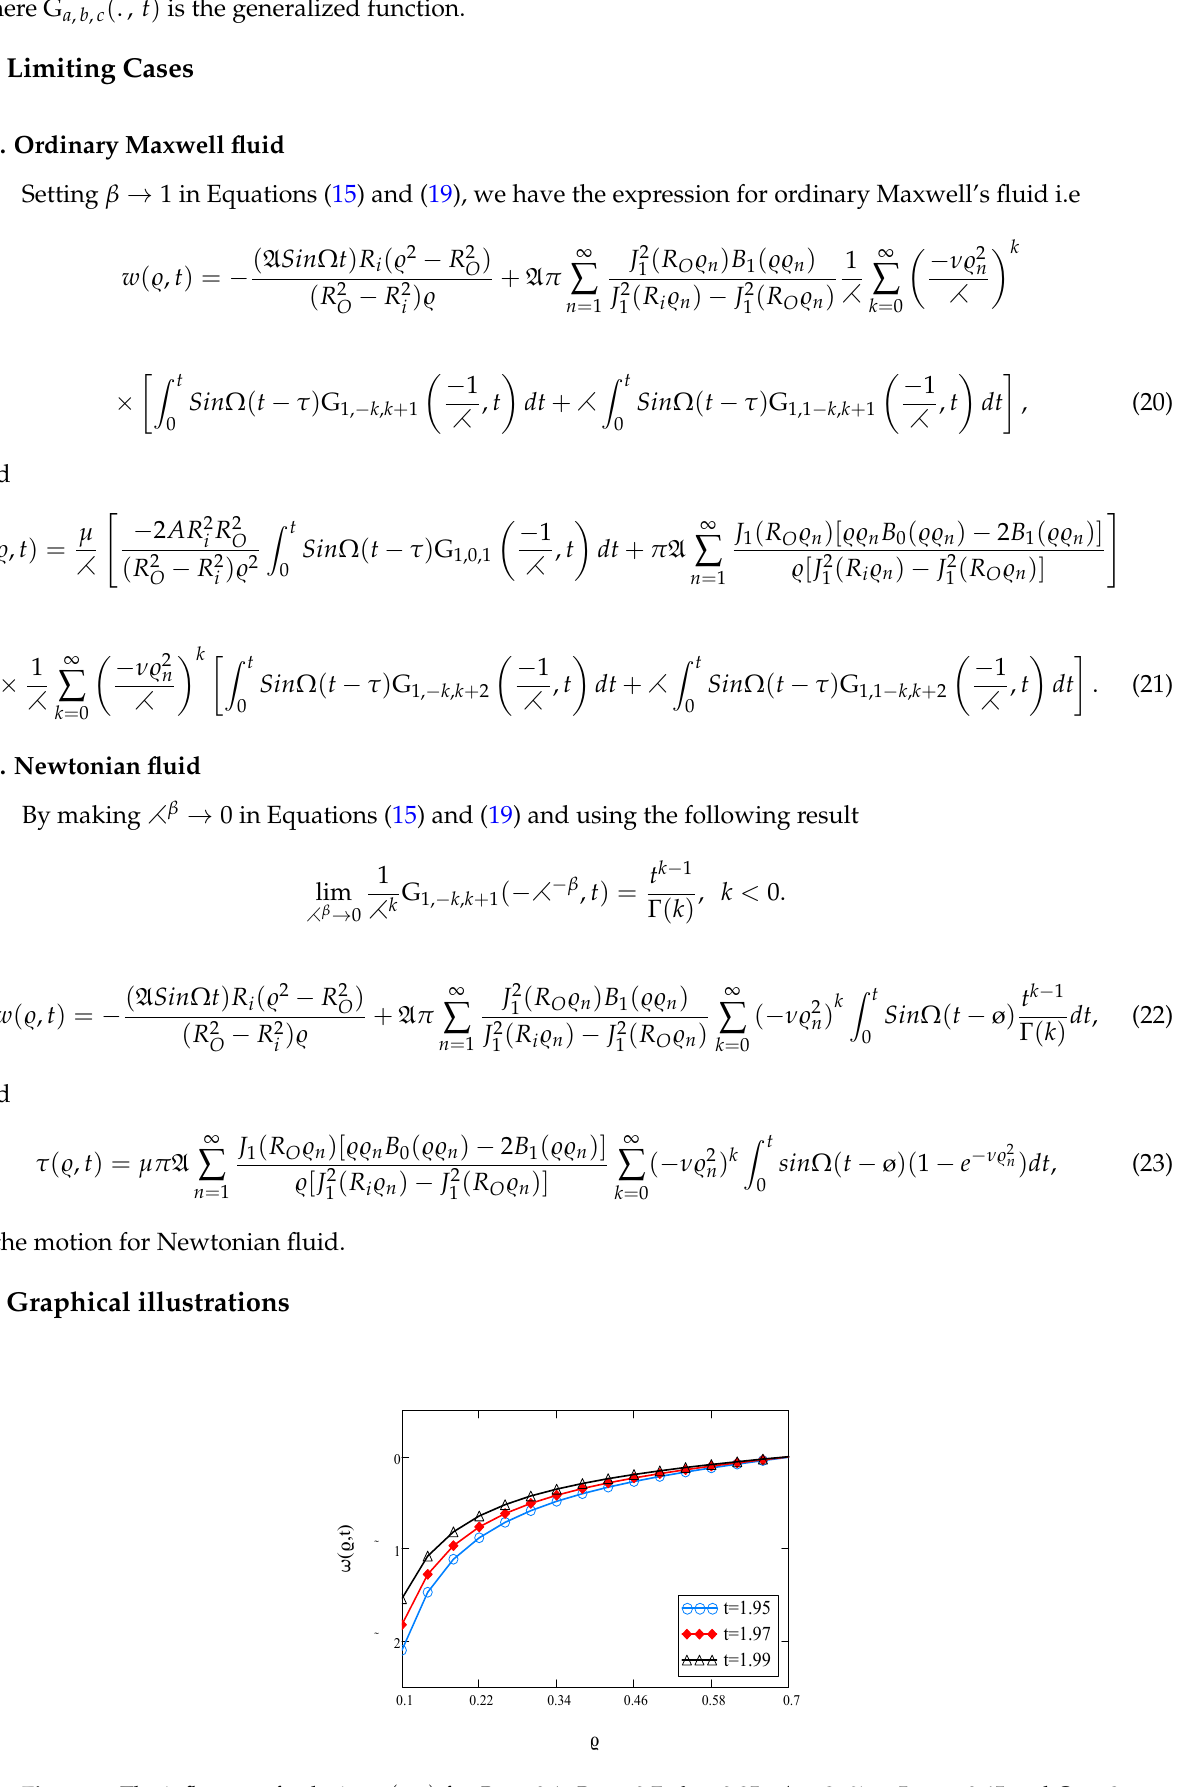
Figure 2. The influence of velocity w ( (cid:36) , t ) for R i = 0.1, R o = 0.7, β = 0.85, (cid:105) = 2, A = 5, ν = 0.45 and Ω = 3 with various values of time